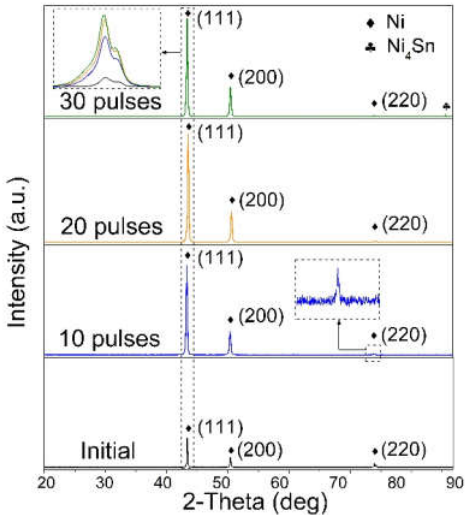
Figure 1. XRD patterns of Ni-Sn samples before and after HCPEB